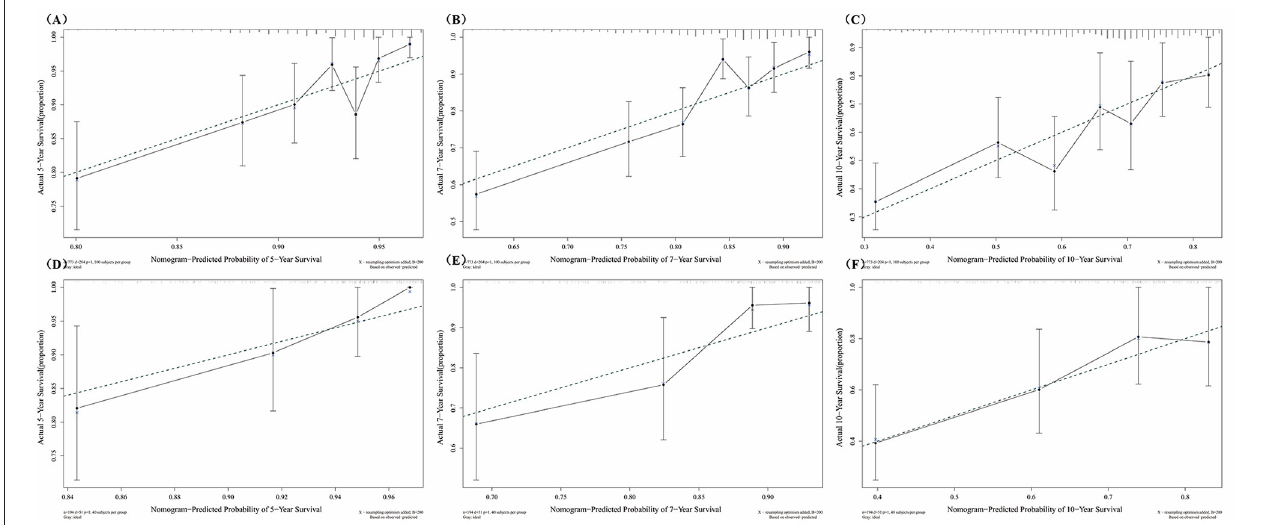
FIGURE 5 | Calibration curves at different survival times in the training set and test set. (A) Calibration curves of 5-year survival, in the training set; (B) Calibration curves of 7-year survival, in the training set; (C) Calibration curves of 10-year survival, in the training set; (D) Calibration curves of 5-year survival, in the test set; (E) Calibration curves of 7-year survival, in the test set; (F) Calibration curves of 10-year survival, in the test set.